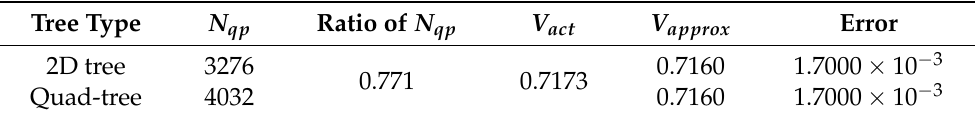
Figure 26. Quadrature points generated for the example in Figure 24b using a kd-tree data structure with two sub-levels. Table 8. Comparison of kd-tree and quad-tree cell division for quadrature cell refinement in the presence of multiple inclusions with elliptical boundary (shown in Figure 24a).